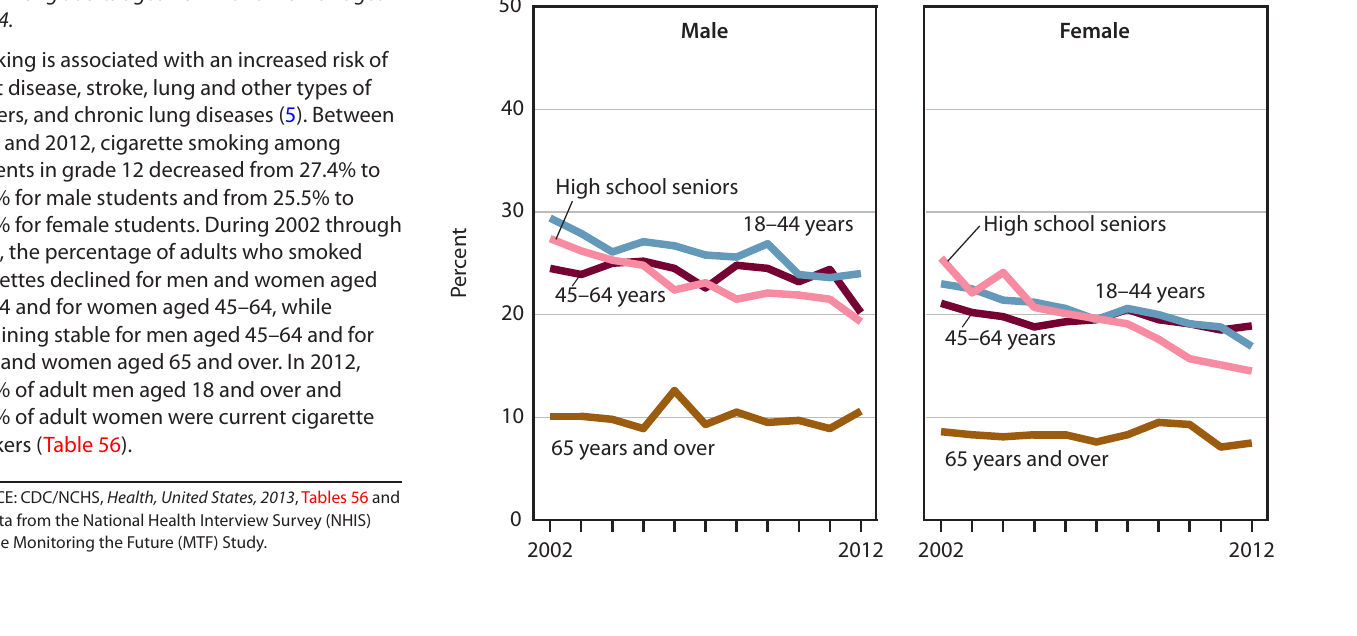
Figure 8. Current cigarette smoking among high school seniors and adults aged prevalence declined among high school